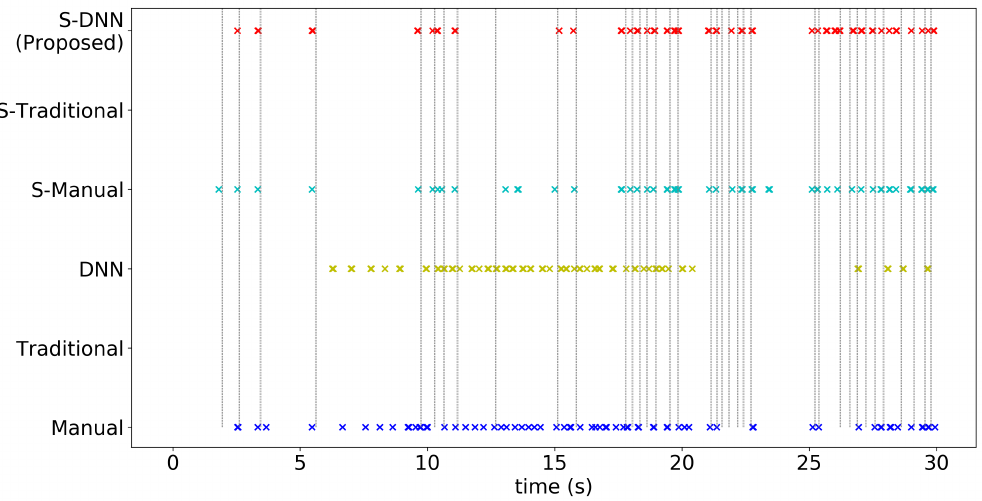
Figure A8. Prediction consistency of event counting compared with ground truths for capillary